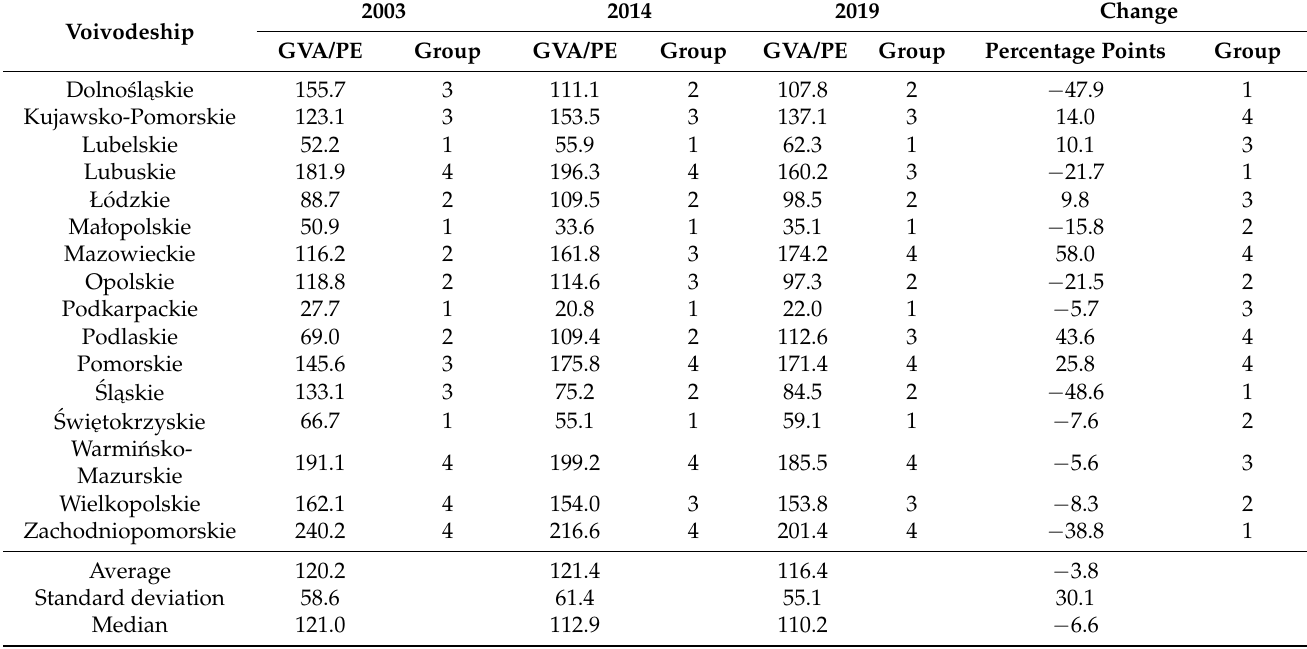
Figure 2. Distribution of the relative gross value added per person employed in section A (agriculture, forestry, hunting, and fishing) for voivodeships in 2003, 2014, and 2019. (Own study, based on the Local Data Bank). Table 4. Distribution of the relative gross value added per person employed in section A (agriculture, forestry, hunting, and fishing) for voivodeships (in %) in the initial and final years of the analysis 1